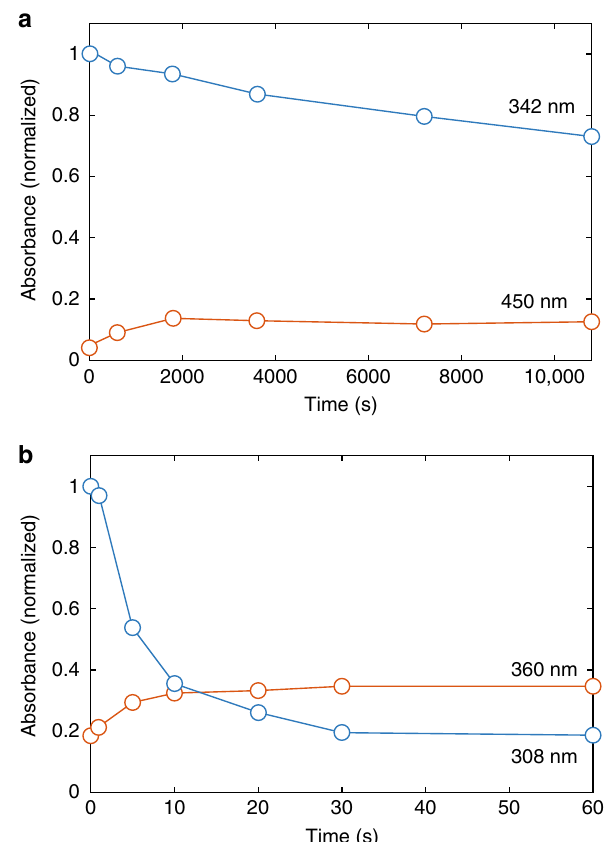
Fig. 2 Reaction rate of redox mediators with singlet oxygen. Change in absorbance over time normalized to the initial value upon exposure to 1 O 2 for DMPZ ( a ) and TTF ( b ) as extracted from the spectra in Fig. 1 at the respective peak